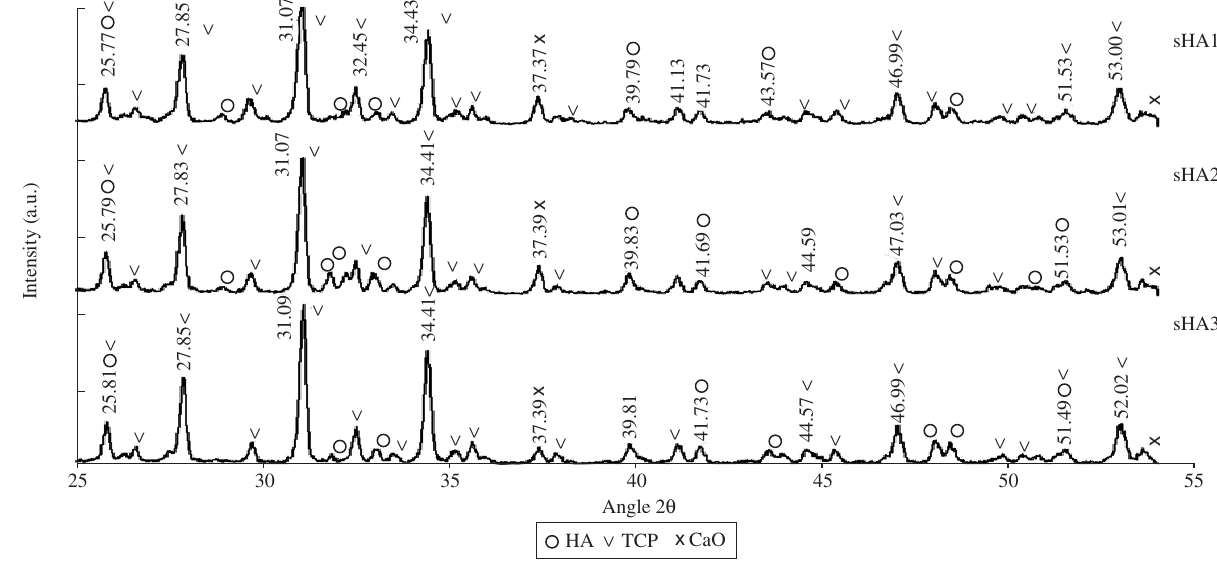
Figure 4. XRD patterns of sintered products from methods 1, 2 and 3.